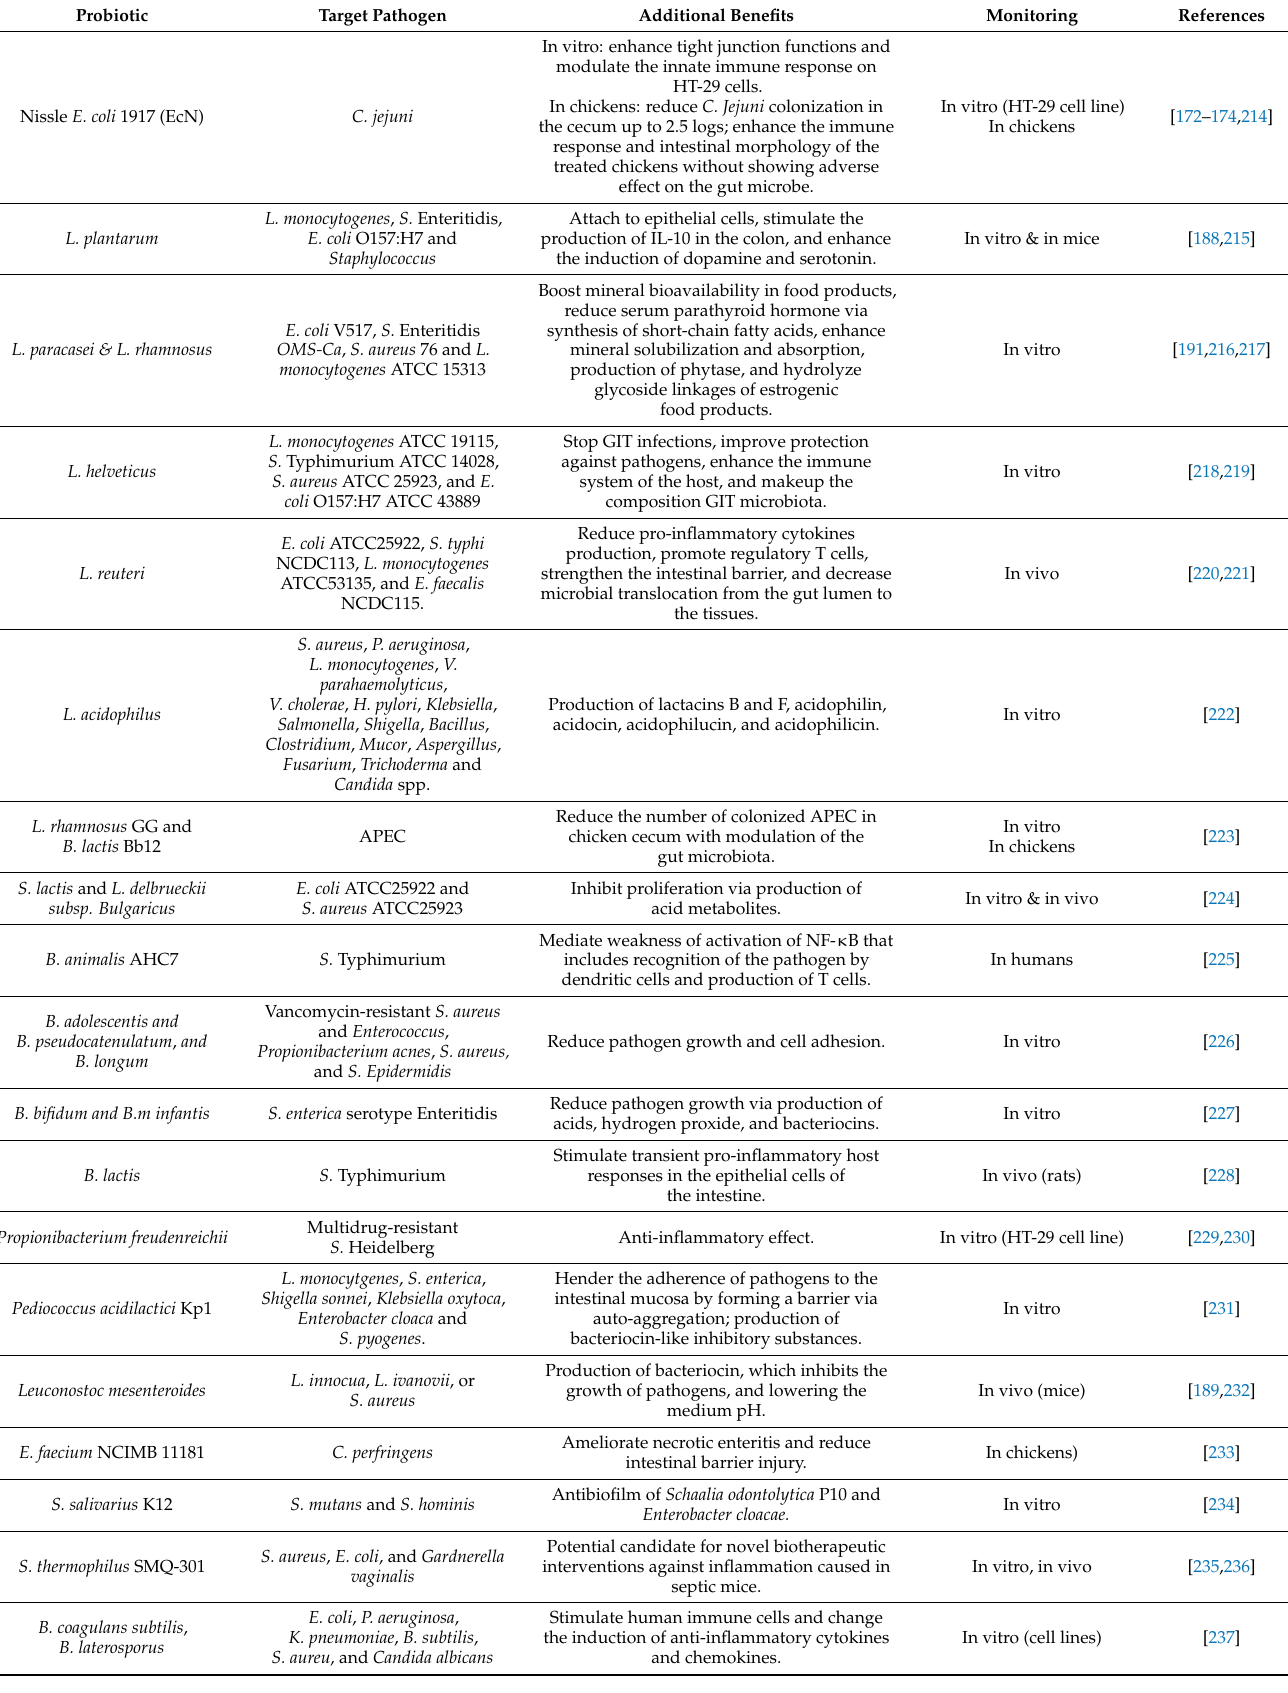
Table 3. Applications of selected probiotics against pathogenic bacteria and their mode of